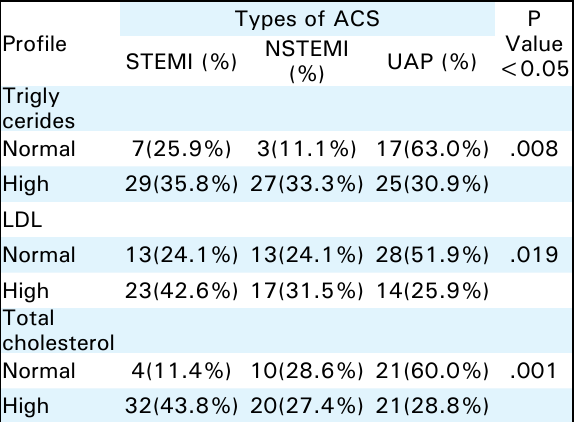
table 7. Correlation between Types of ACS and Lipid profile (n =108).